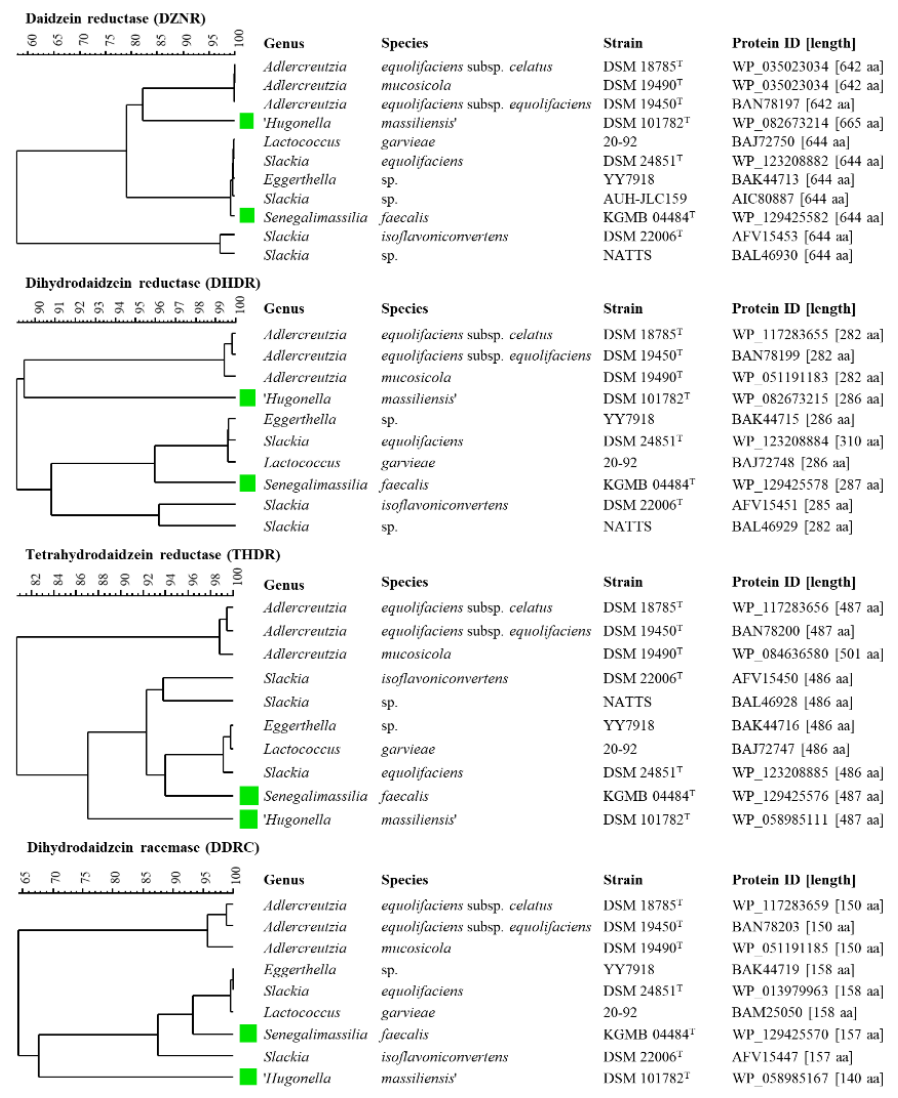
Figure 2. Cluster analyses of amino acid sequences of daidzein reductase (DZNR), dihydrodaidzein reductase (DHDR), tetrahydrodaidzein reductase (THDR), and dihydrodaidzein racemase (DDRC) of strains of the Eggerthellaceae and Coriobacteriaceae . Clustering was performed by multiple-alignment and UPGMA (unweighted pair group method with arithmetic mean) in BioNumerics 8.0. Green labeled strains are not yet described in the literature to be associated with daidzein or genistein metabolism, to the best of our